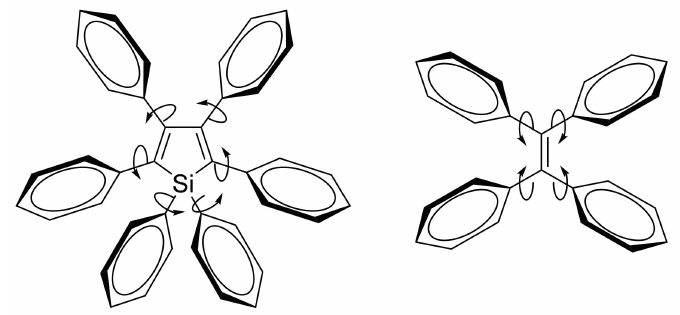
Figure 1. Structure of hexaphenylsilole (HPS) and tetraphenylethylene (TPE), illustrating the free rotation of the phenyl rings in solution.